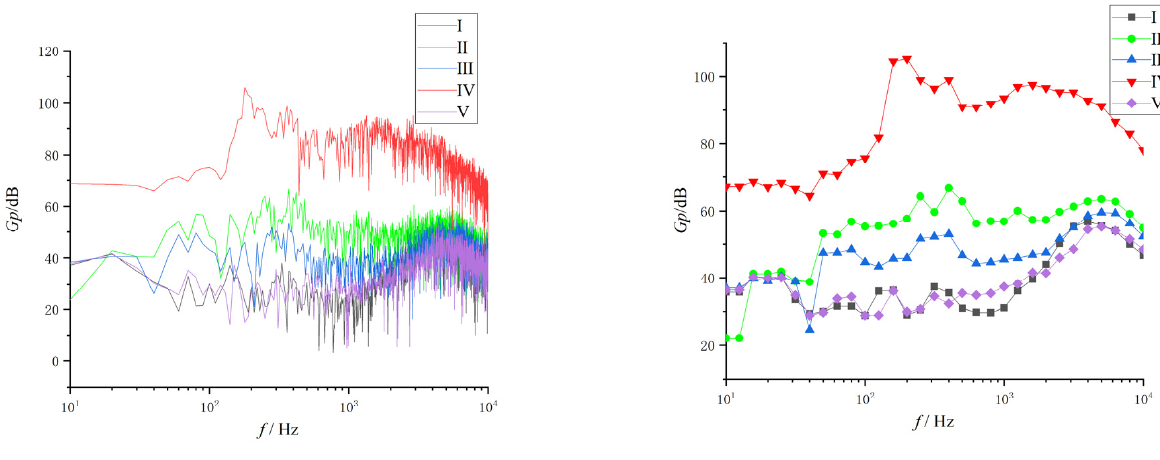
Figure 15. The self-power spectral of the pressure fluctuation at the velocity of 5.93 kn. (I) Re s = 1.349 × 10 5 , (II) Re s = 6.060 × 10 5 , (III) Re s = 7.409 × 10 5 , (IV) Re s = 8.760 × 10 5 , (V) Re s = 1.482 × 10 6 .